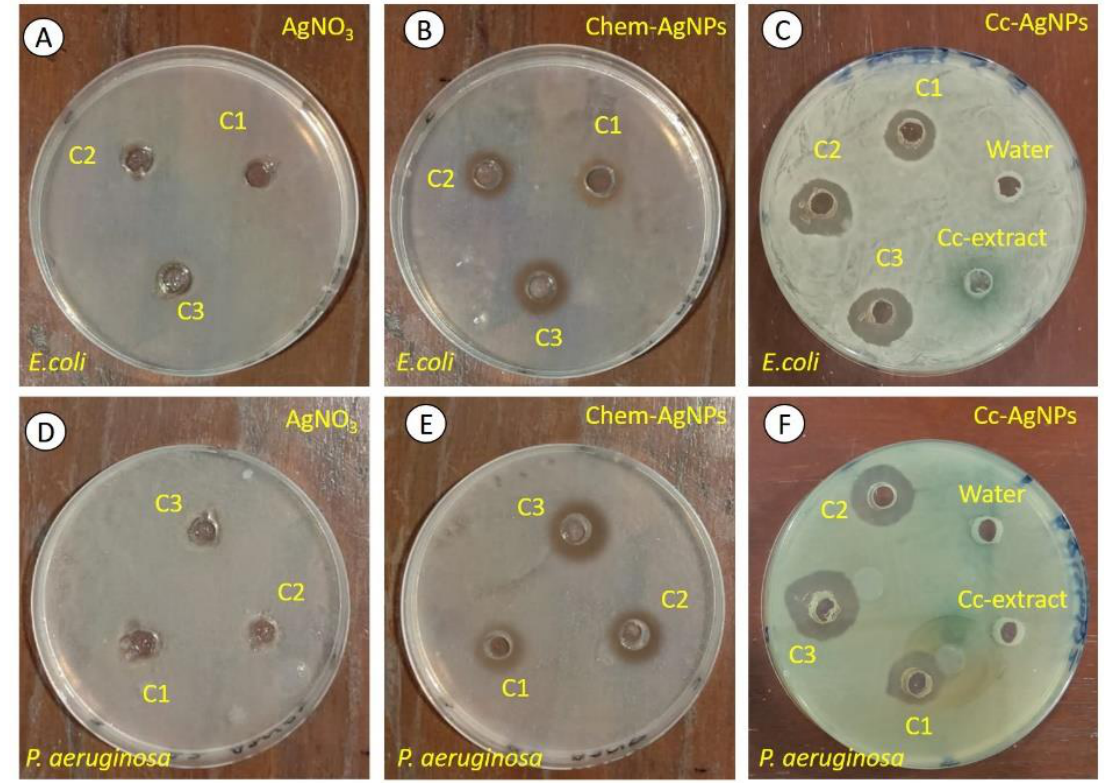
Figure 4. Zone of inhibition (ZOI) showing the bactericidal efficacy of AgNO 3 ( A , D ), Chem-AgNPs ( B , E ), and Cc-AgNPs ( C , F ) at different concentrations — C1: 25 µg/mL; C2: 50 µg/mL, and C3: 100 µg/mL — against E. coli (upper panel) and P. aeruginosa (lower panel). Antibacterial activity of DI water and Cc extract against both strains is shown ( C , F ).